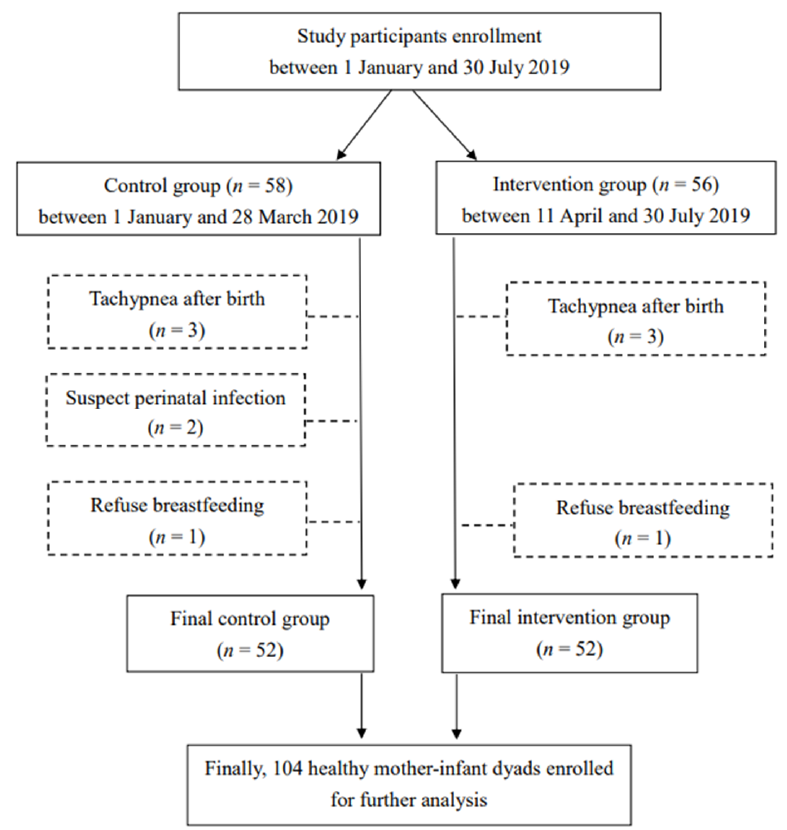
Figure 1. The flow of study participants.